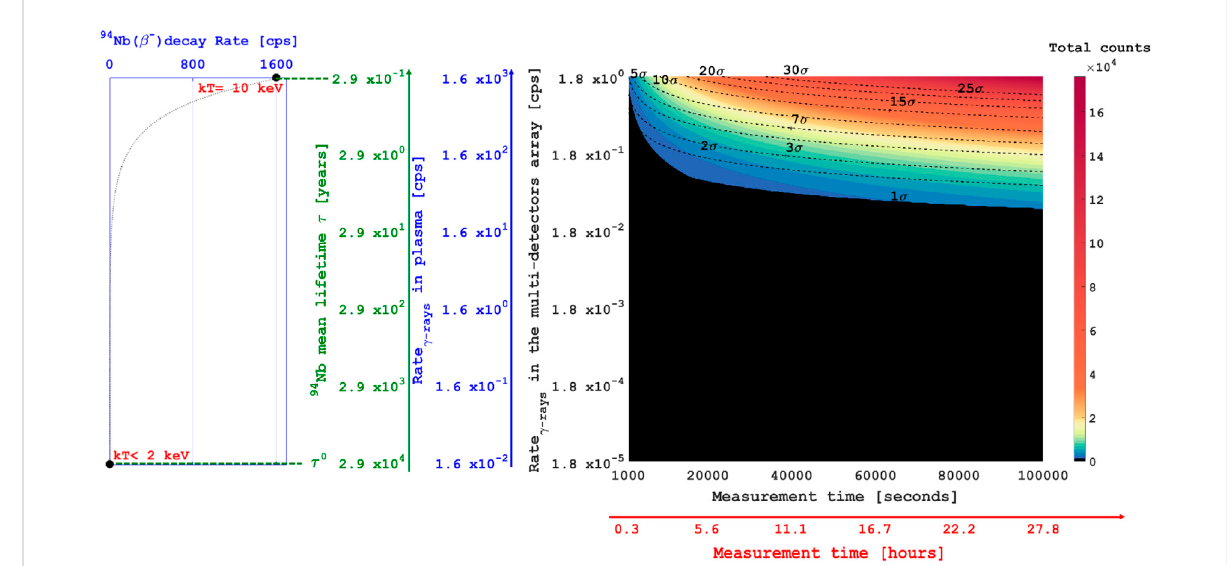
FIGURE 12 Total counts of gamma-rays emitted (pseudo-colors scale) and iso-signi fi cance contours (dashed lines) for different 94 Nb isotope lifetimes (green vertical axis) as a function of the measurement lifetime. Blue and black vertical scales show the predicted decay rate in plasma and the counting rate measured in the array associated to the different isotope lifetime.